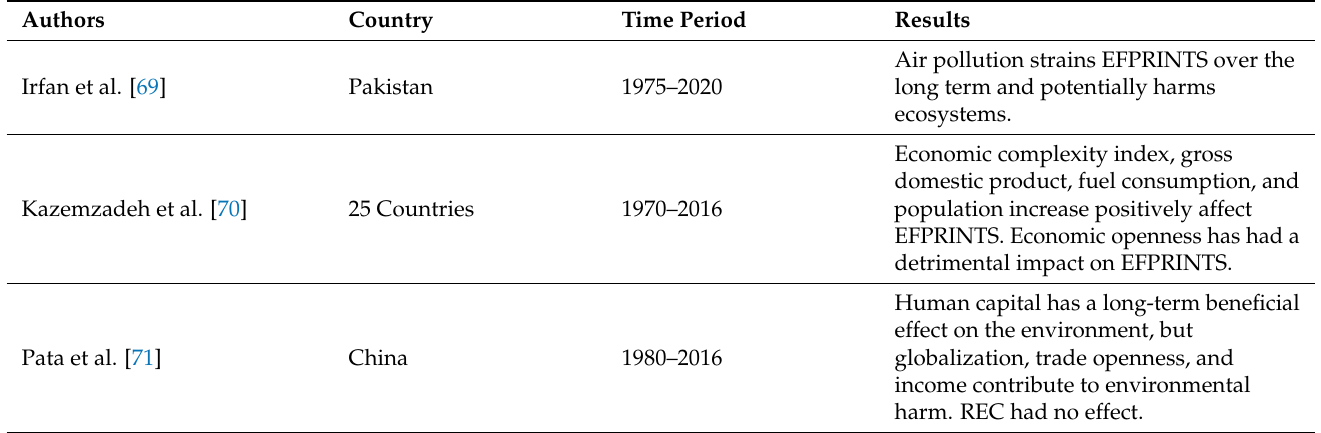
Table 1. Ecological footprints literature